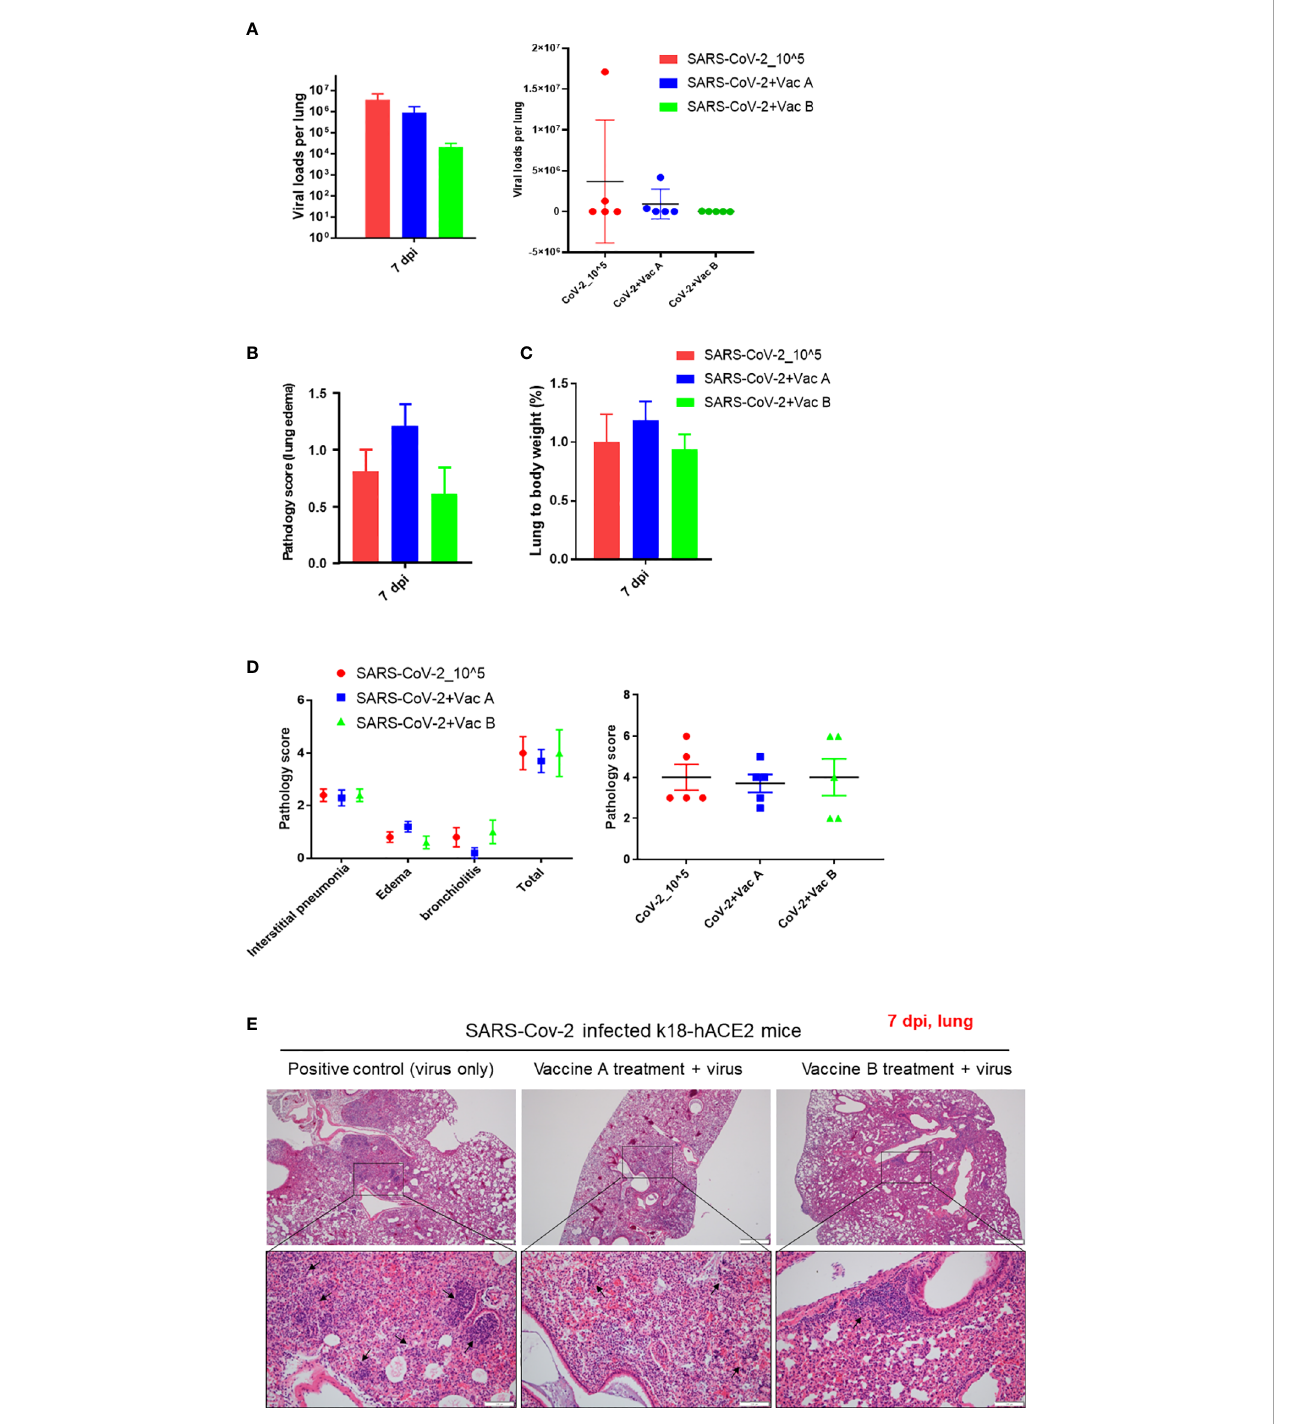
FIGURE 4 Pathological changes of K18-hACE2 TG mouse lungs after SARS-CoV-2 infection with and without vaccine. (A) The viral load measurements in the three groups of mice; vaccine A-administered group, vaccine B-administered group, and SARS-CoV-2-infected group (each n = 5) represented as cumulative viral load in each group in the left bar graph. The viral load measurements showed individual viral load in each mouse within the three groups of mice as represented in the right graph. Means with SD are presented, and there was no signi fi cance among groups. (B) Histopathological score of changes in lung edema. (C) Lung to body weight %. (D) Total pathology score. (E) Histopathology of mouse lungs after being paraf fi n-embedded, cut, and stained with hematoxylin – eosin (H&E). Lung granulomas are indicated in black arrows. Scale bars 50 µm (upper line) and100 µm (lower